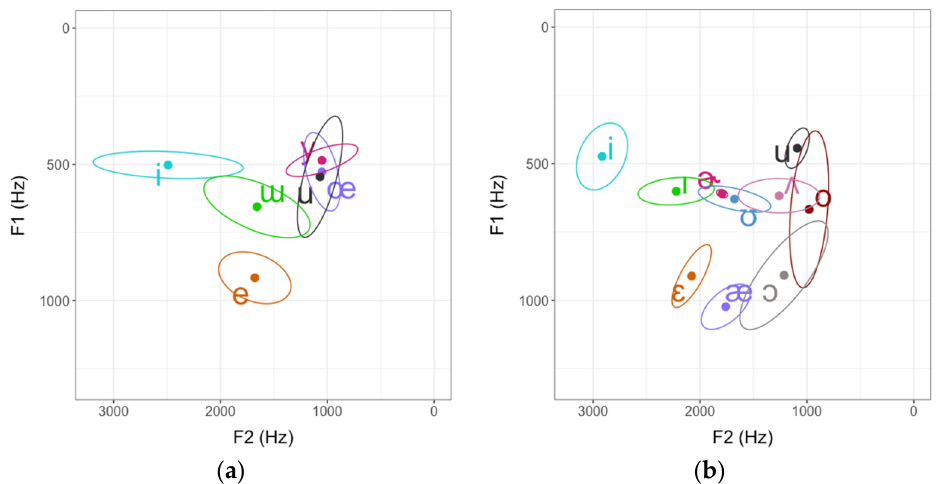
Figure 8. ( a ) Mean F1 and F2 values for L2 Turkish vowels produced by speaker F07. Each ellipse includes approximately 95% of the samples in each vowel category. ( b ) Mean F1 and F2 values for L1 English vowels produced by speaker F07. Each ellipse includes approximately 95% of the samples in each vowel category.